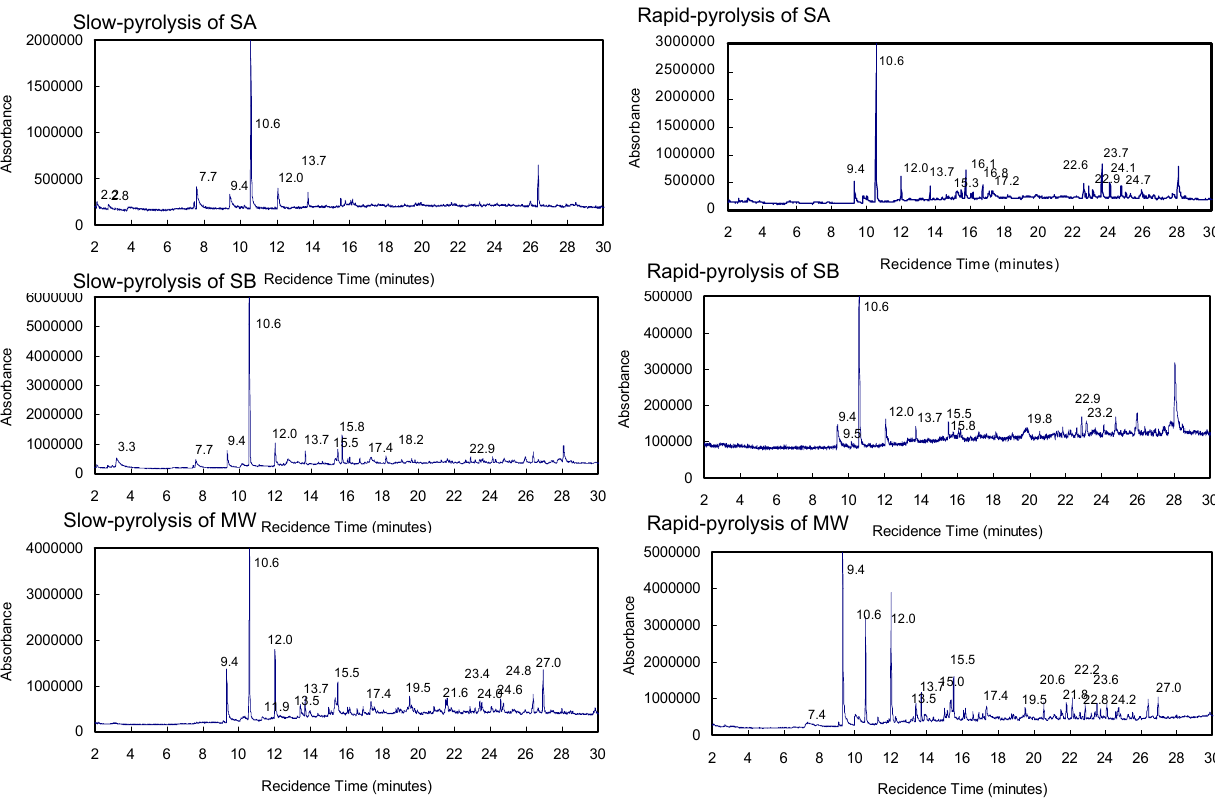
Figure 7. Major nitrogenous tar compounds identified by the